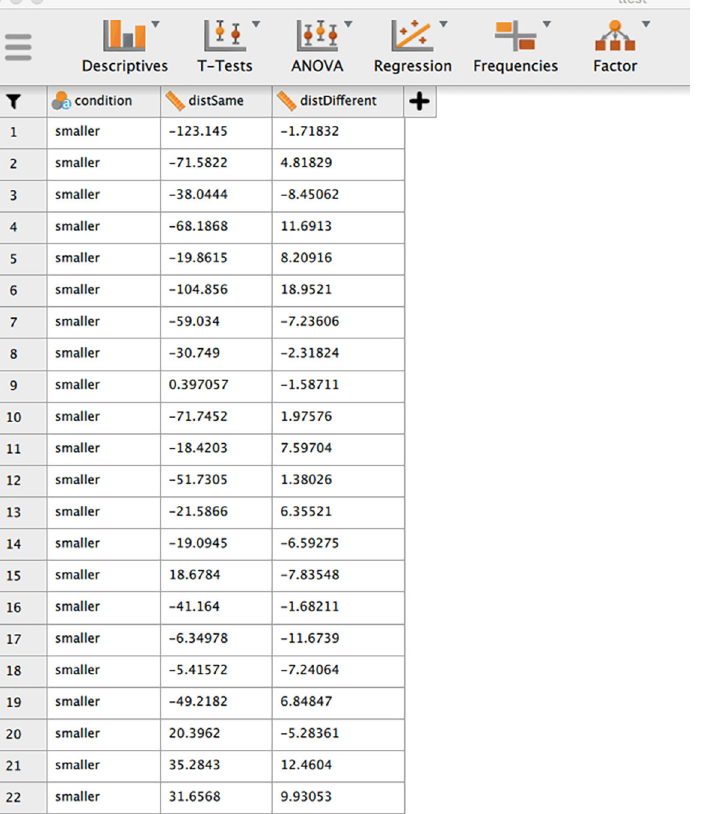
Similar to Verguts and De Moor (2005), we are interested in whether the mean of the regression slopes (col- lapsed across participants by condition) depends on the type of decade pair being compared. Specifically, the decomposed processing account leads us to predict that for same-decade pairs, the numerical